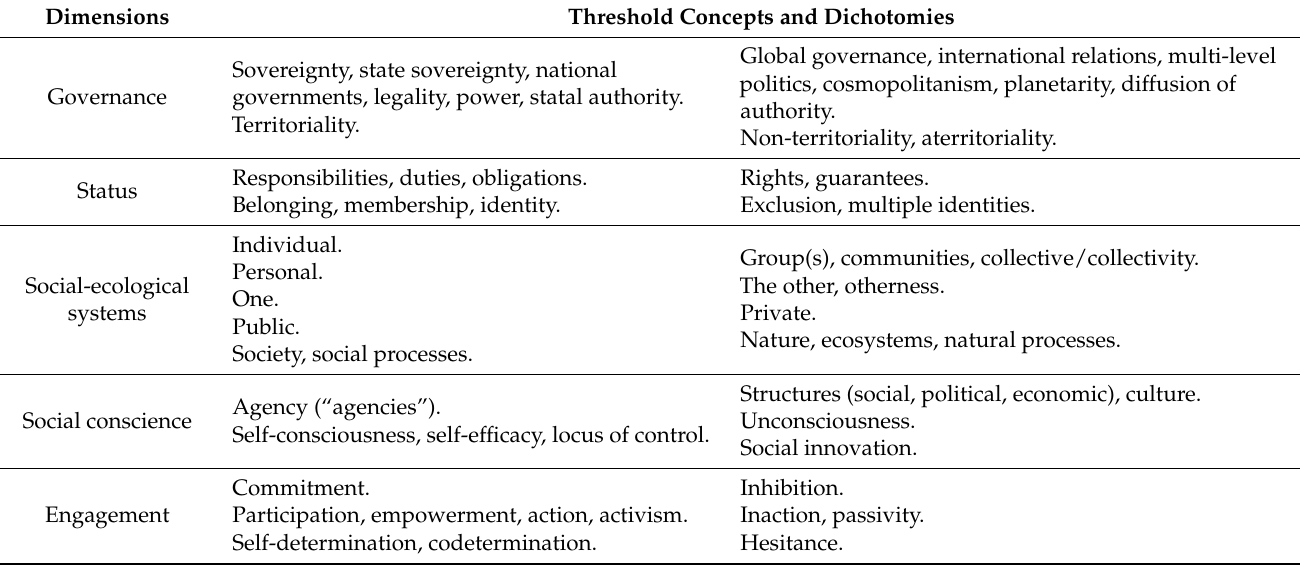
Table 3. Key dimensions and threshold concepts of sustainable global citizenship, from a critical realist